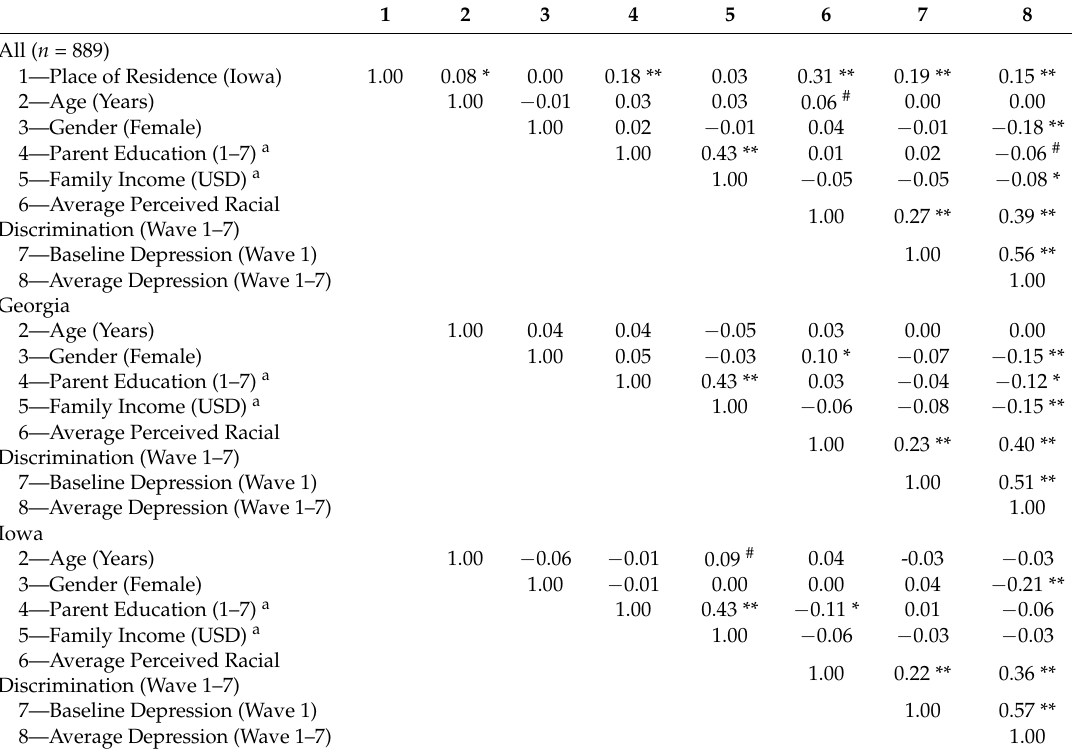
Table 2. Correlation matrix of the study variables ( n =